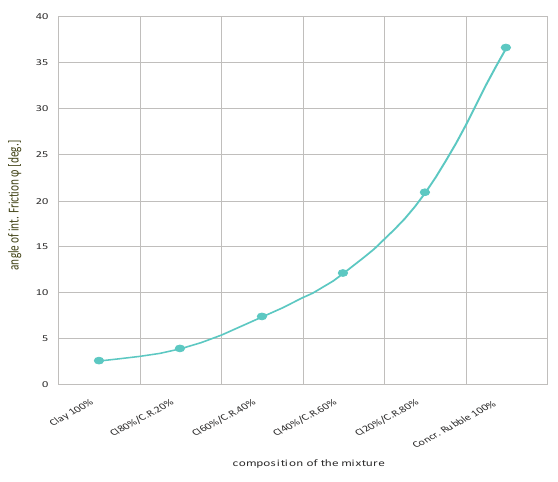
Figure 7: Change in the angle of internal friction ϕ , depending on the composition of the mixture.